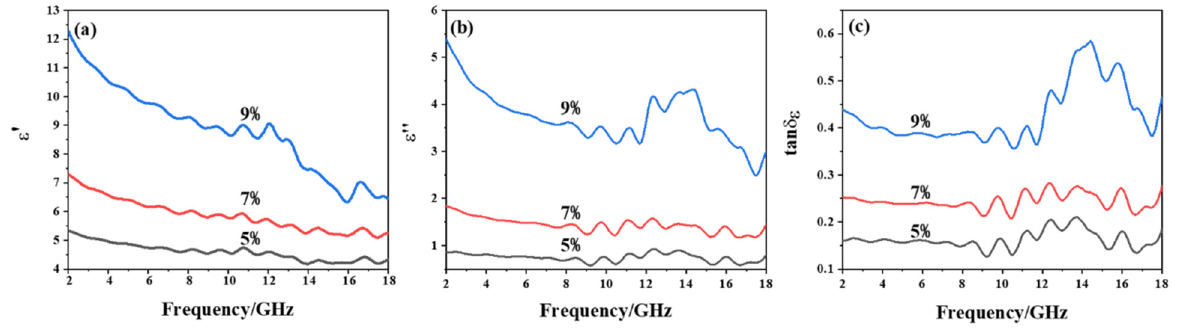
Figure 3. Complex permittivity of PCNF composites: ( a ) real part of complex permittivity; ( b ) imaginary part of complex permittivity; ( c ) loss factor.